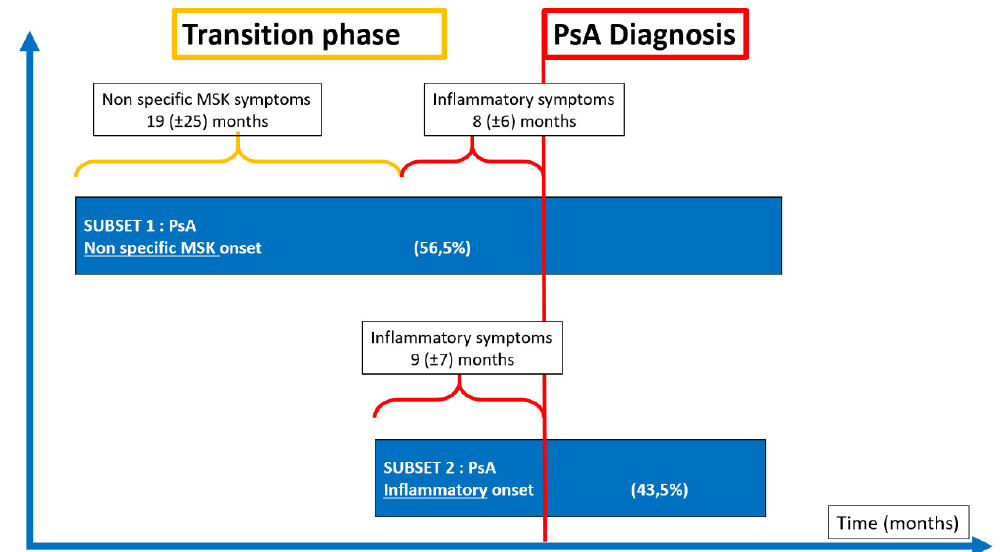
Figure 1. Clinical onset characteristics of 88 patients with a new diagnosis of psoriatic arthritis (PsA), followed in the Early Arthritis Clinic in Udine (Italy), MSK: musculoskeletal.